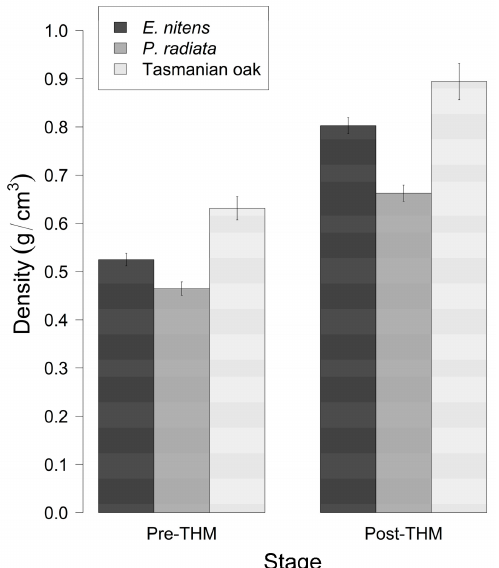
Figure 2. Density before (Pre-THM, left) and after the treatment (Post-THM, right) of the three species (black, E. nitens ; dark grey, P. radiata ; and light grey Tasmanian oak). The line on the bar represents the standard